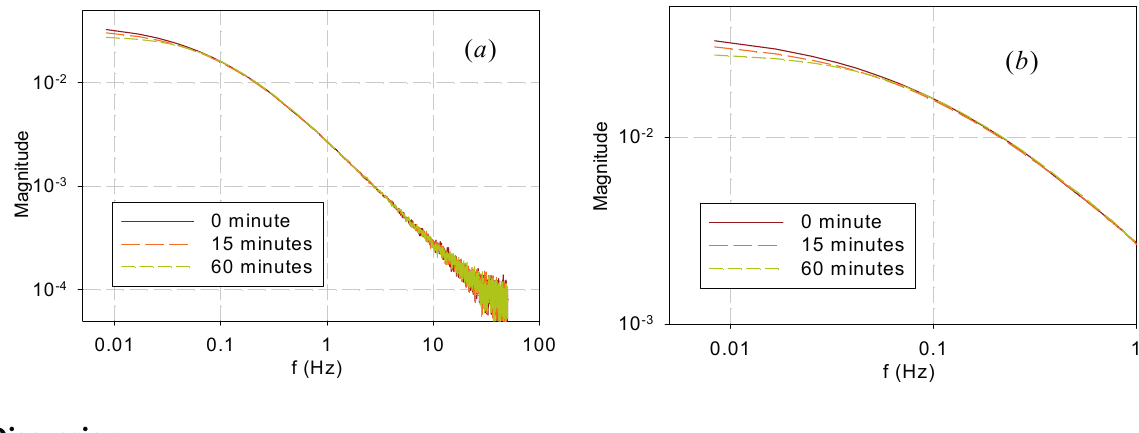
Figure 5. DF spectra of garden bean leaves at different herbicide binding times ( a ) Full computed spectra; ( b ) Zoom-in to show